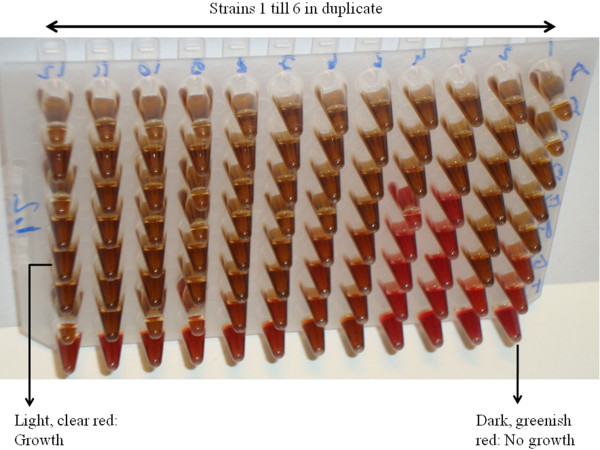
MIC-testing of DQC in microtiterplate broth format. MIC: Minimal Inhibitory Concentration, DQC: dequalinium chloride.